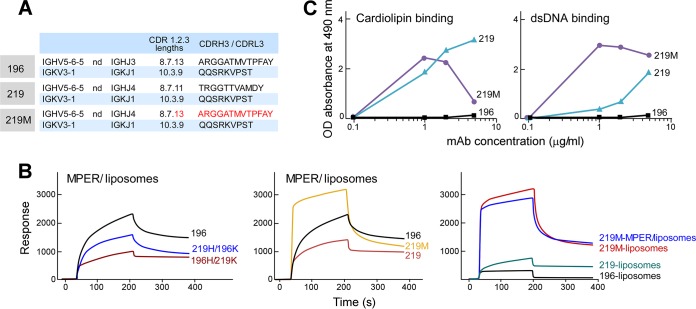
Reverse correlation between MPER binding and polyreactivity determined by chain swap and/or CDRH3 mutations. (A) IgH and IgLk V(D)J gene usage of related Abs 196 and 219. 219M is a 219 variant in which CDRH3 of clone 219 was replaced by CDRH3 of clone 196. (B) Relative binding reactivities to MPER/liposomes as assessed by SPR analysis of chimeric rMAbs from clones 196 and 219 compared to that of naturally paired clone 196 (left panel). Also shown are 219M binding reactivities for MPER/liposomes (middle) and liposomes only (right) in comparison to those of WT clones 196 and 219. Thirty microliters of each antibody at 100 μg/ml was injected over the MPER/liposome or liposome surface of an L1 chip at a flow rate of 10 μl/min for 3 min. (C) rMAbs were tested for polyreactivity by cardiolipin and dsDNA ELISAs.